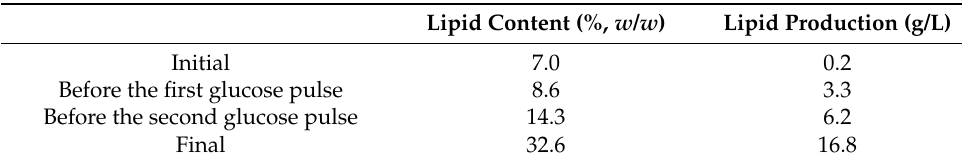
Table 5. Lipid content and lipid production by C. curvatus at the start and end of the test and before the two glucose pulses added.